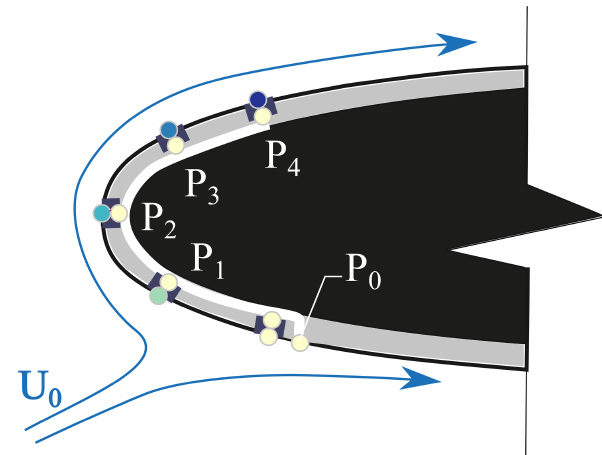
Figure 9. Sketch of differential pressure sensors at the leading edge. The reference pressure P 0 is taken at a point in the leading edge area on the pressure side. Four other sensors record the difference in pressure between their locations and the reference pressure.